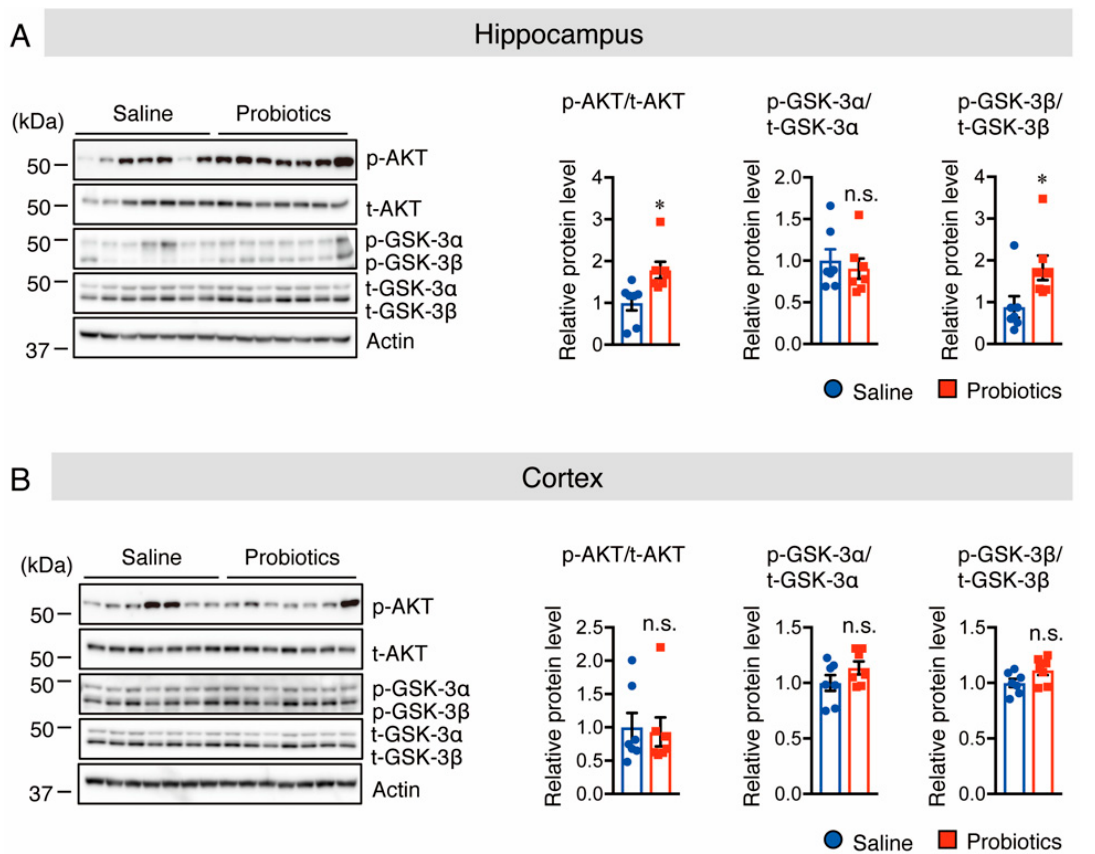
Figure 4. Oral supplementation of B. breve MCC1274 increases Akt and p-GSK-3 β phosphorylation levels, but not GSK-3 α phosphorylation levels, in the hippocampus of WT mice. Western blot analysis of phosphorylated (p-) Akt, total (t-) Akt, p-GSK-3 α / β , t-GSK-3 α / β , and actin in the hippocampus ( A ) and cortex ( B ). Quantification of phosphorylated (p-) protein levels normalized to total (t-) protein levels and expressed as values relative to the control. Data are represented as mean ± SD, n = 7 per group; n.s. no significant difference; * p < 0.05 compared with the saline group, as determined by Student’s t -test.